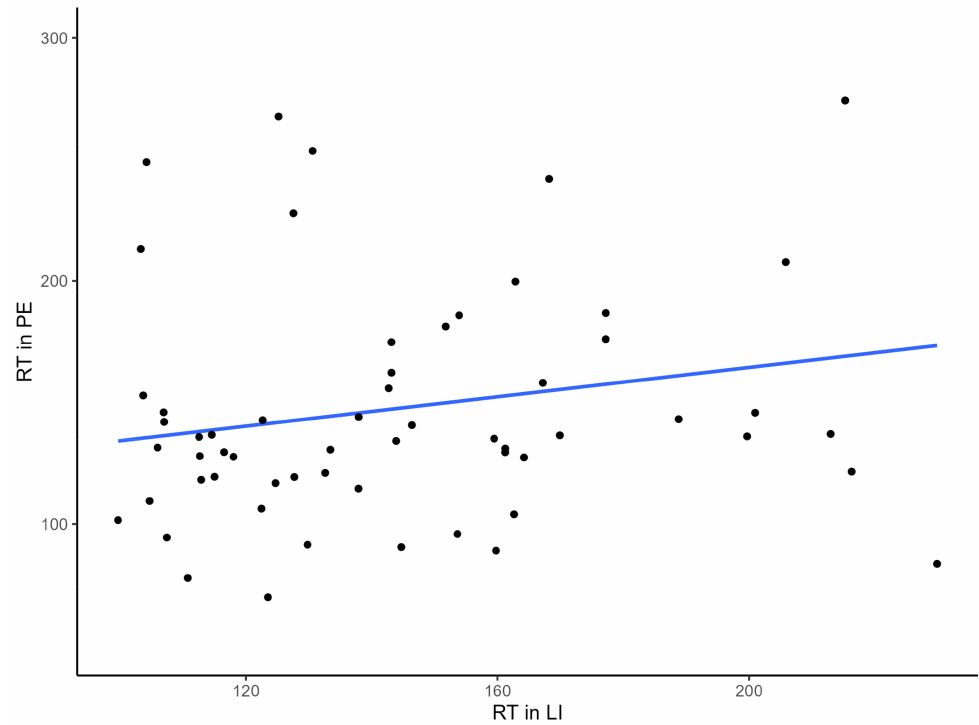
Figure 4. A scatter plot and linear fit illustrating the relationship between reaction time in the LI and PE